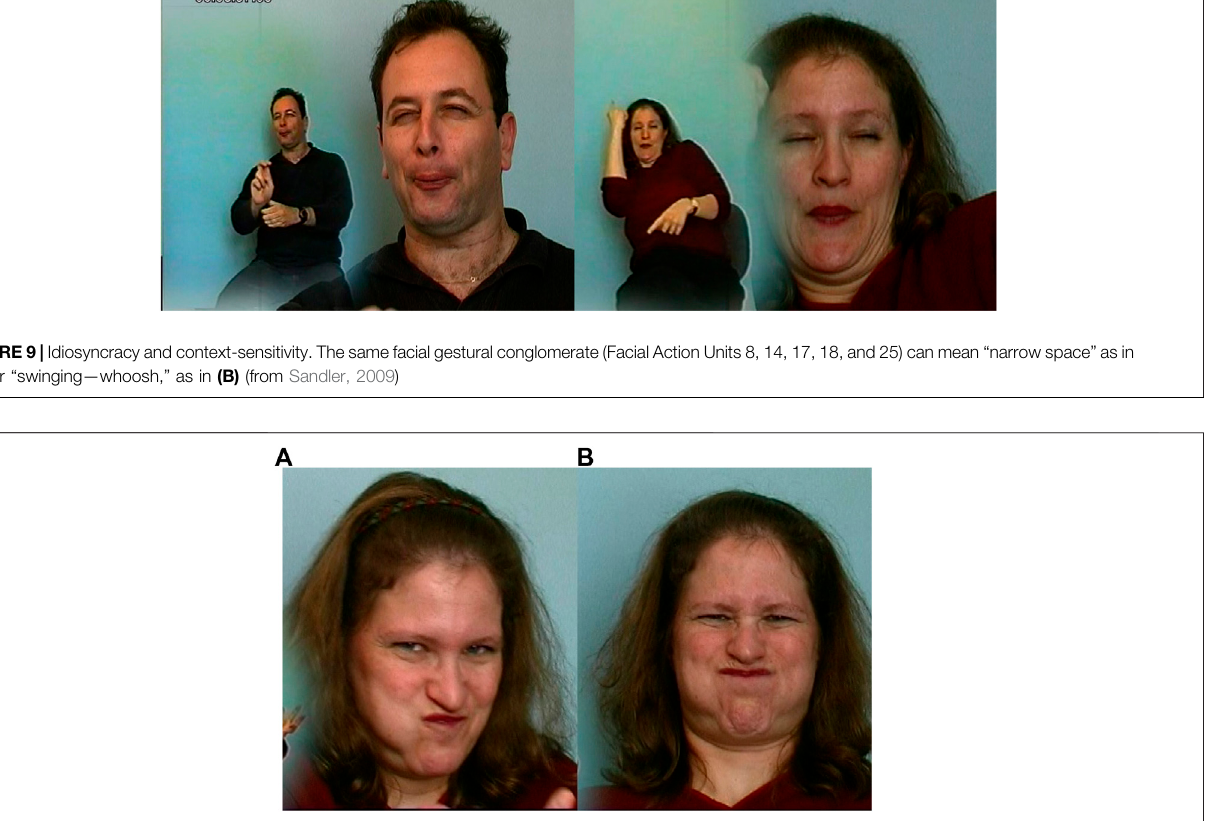
FIGURE 10 | Gradience: (A) one cheek puffed to describe a bowling ball and (B) two cheeks puffed to describe the cat ’ s body after swallowing the bowling ball (Sandler, 2009)